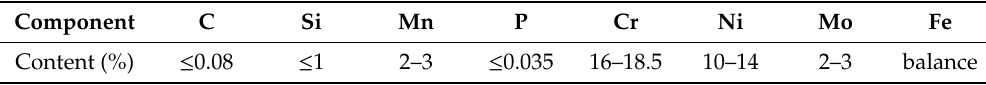
Table 1. Chemical composition of 316L stainless